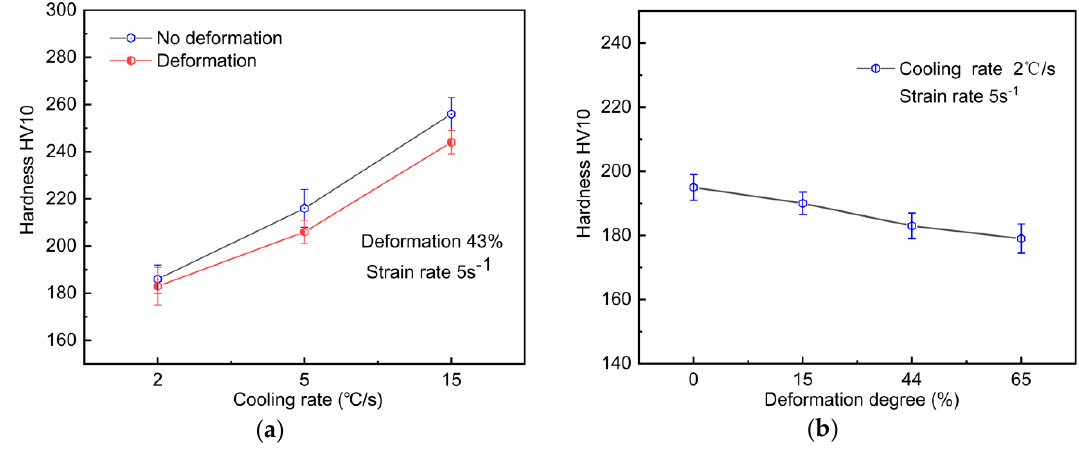
Figure 16. Effects of deformation ( a ) and cooling rate ( b ) on the macrohardness of TC# steel.